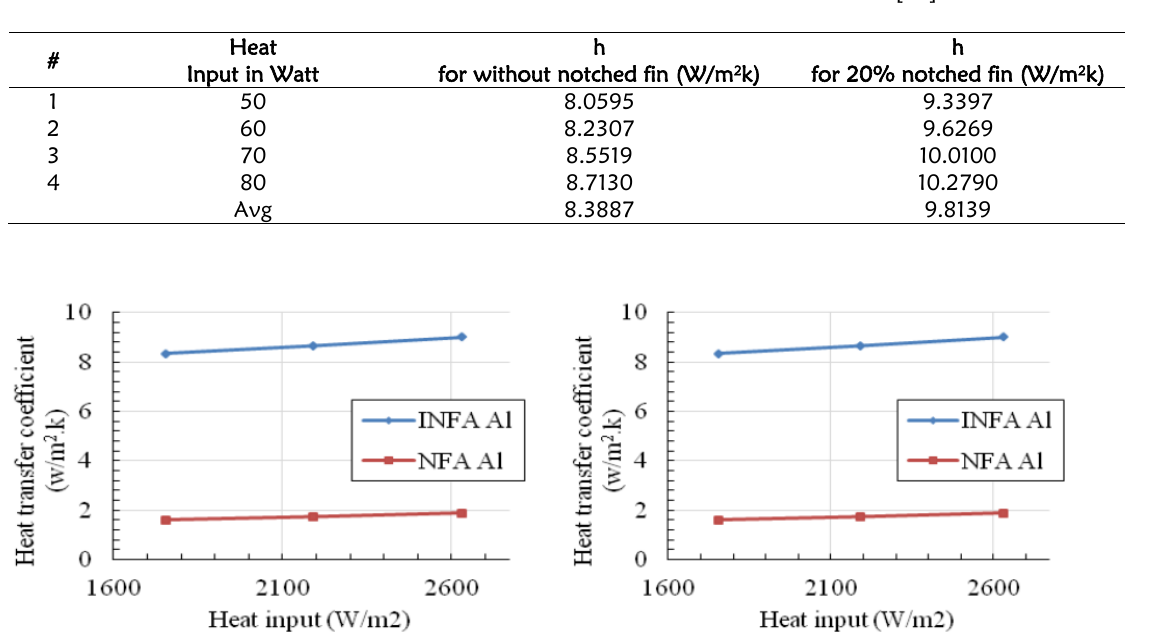
Table 1: Heat transfer coefficient for without notched and notched fins [40]